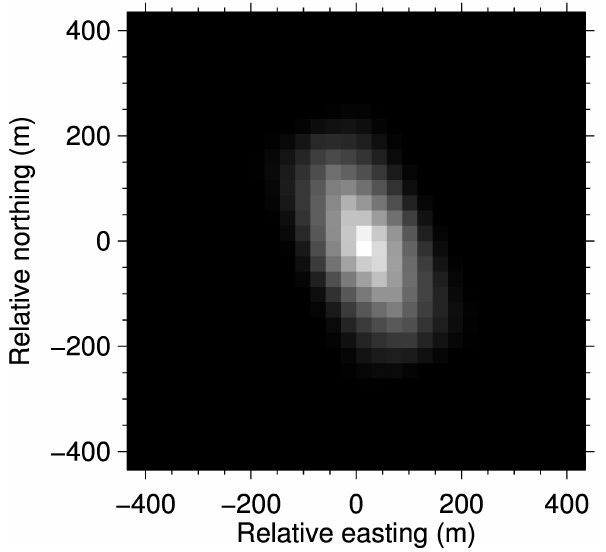
Figure 2. Modeled spatial response of a nadir RSP measurement where the long direction is along track (scan direction).